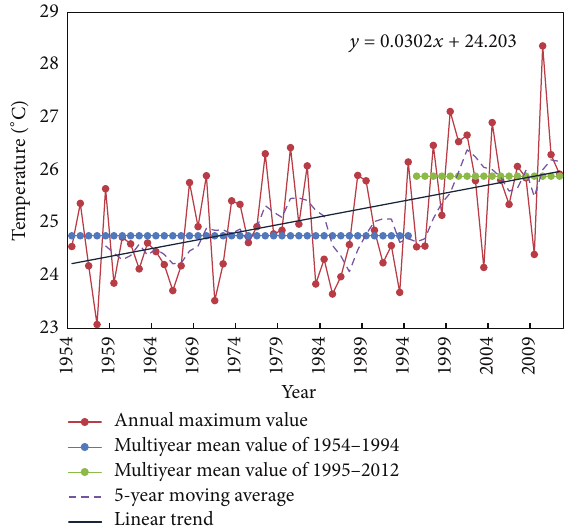
Figure 7: Long-term changes in area-averaged annual maximum temperature ( ∘ C) in the Amur River